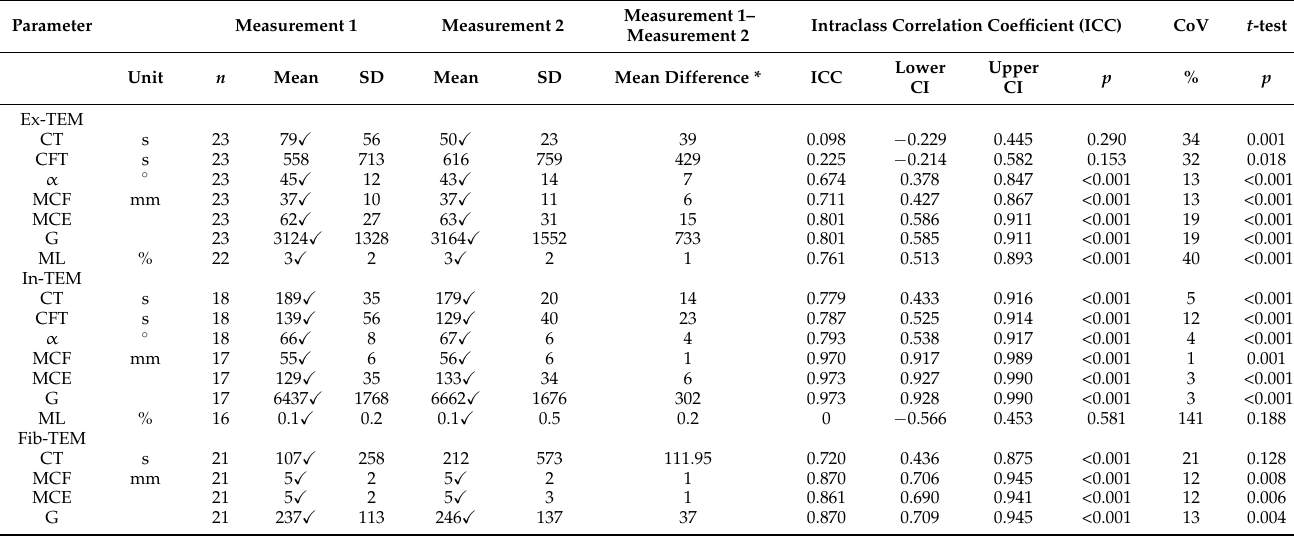
Table 3. Comparison of paired simultaneous ROTEM measurements analyzed by the same operator on the same device/Investigation of intra-operator/intrarater